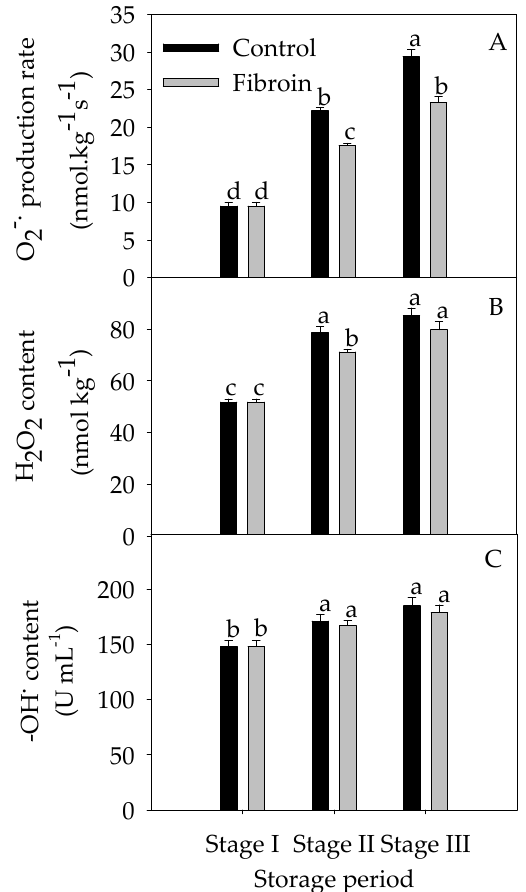
Figure 4. Effects of fibroin treatment on O 2 − . production rate (A) and contents of H 2 O 2 (B) and − OH . (C) in peels of harvested banana fruit during cold storage. The data are presented as means ± standard errors ( n = 3). The means with different letters are significantly different ( p < 0.05).